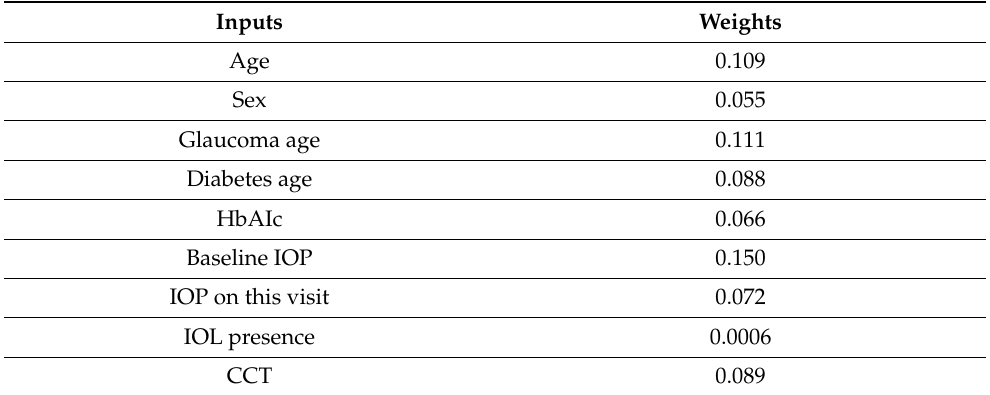
Table 2. The weights for each input in relation to the VFI output calculated with the NNGE